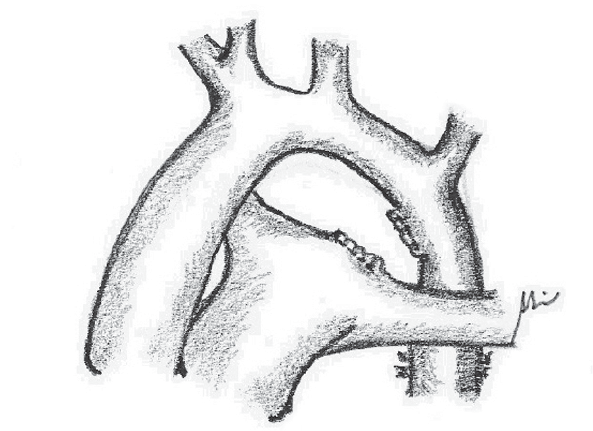
Fig. 4- Ligadura do ducto arterioso